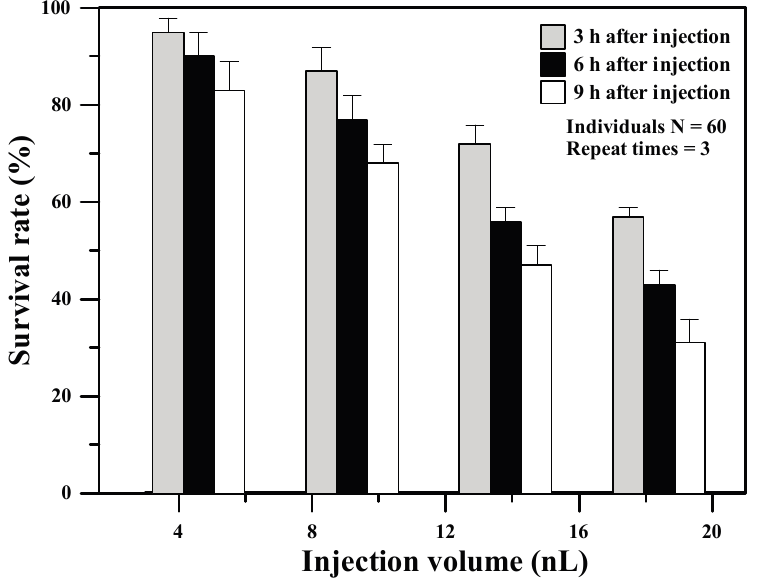
Figure 4. The survival rates (%) of 3–9 h after microinjecting 4.6, 9.2, 13.8, and 18.4 nL of 200 μ M Oxyphor G4 solution into 48 hpf zebrafish